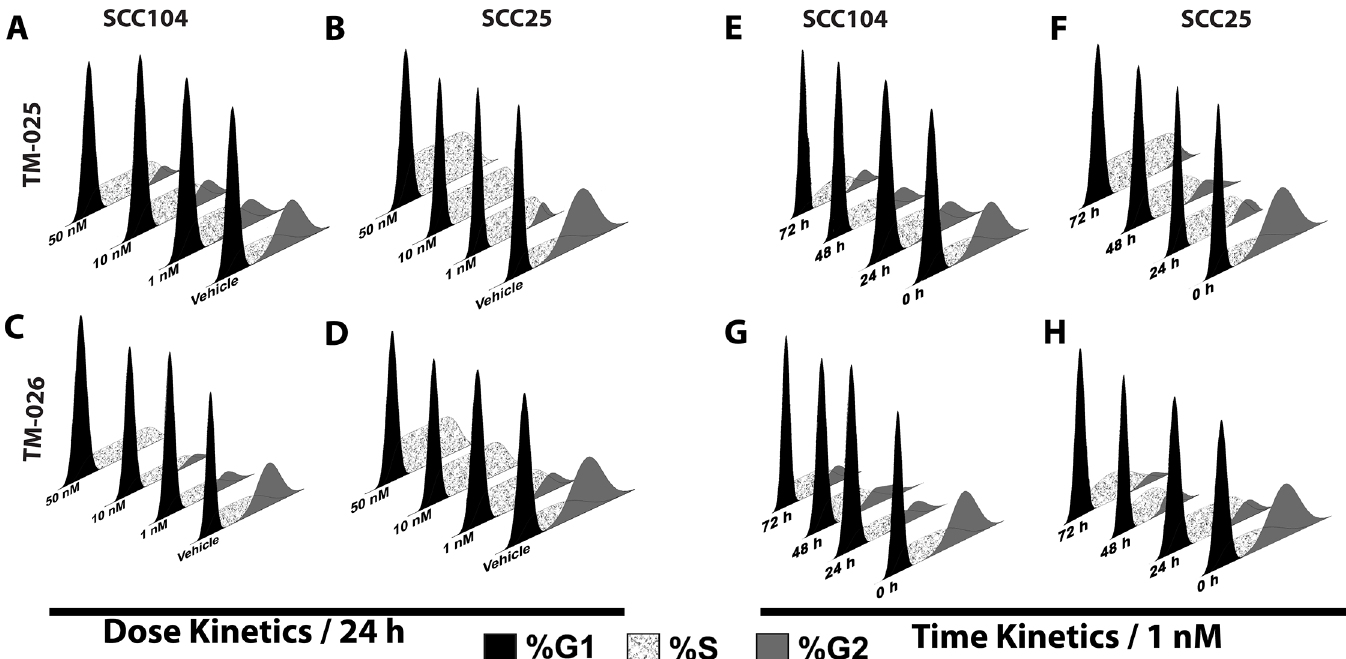
Fig 6. Treatment with PCT analogs altered cell cycle progression in HNSCC cells. Flow cytometry-based cell cycle analysis of SCC104 and SCC25 cells upon treatment with PCT analogs. Dose kinetics (A – D) was determined for a period of 24 h (with 1, 10 and 50 nM doses). A significant decline in the percentage of G 2 cells was observed, along with a considerable augmentation in the percentage of S-phase cells. Time kinetics (E – H), on the other hand, was investigated for 24, 48 and 72 h for a dose of 1 nM. A time-dependent inhibition of cell cycle progression was observed. All results are significant at P < 0.01.